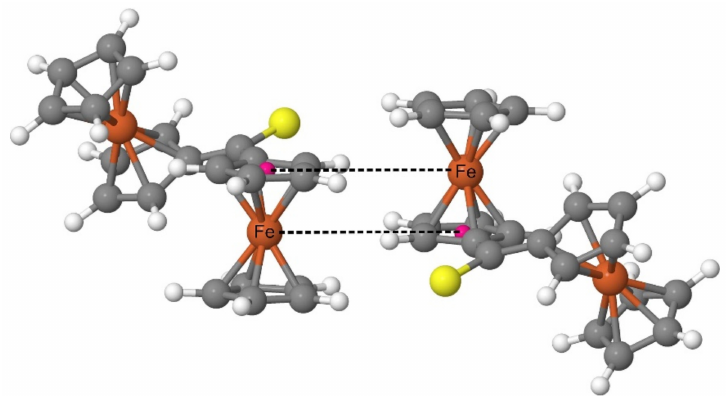
Figure 8. Structural motif extracted from the crystal structure of Fc 2 CS as it was calculated at the PBE-D / SVP level of theory. Geometrical centers of two Cp-rings are marked with small pink balls. Dashed lines link each center with the nearest Fe atom belonging to the neighboring molecule. Colors coding individual elements are the same as in Figure